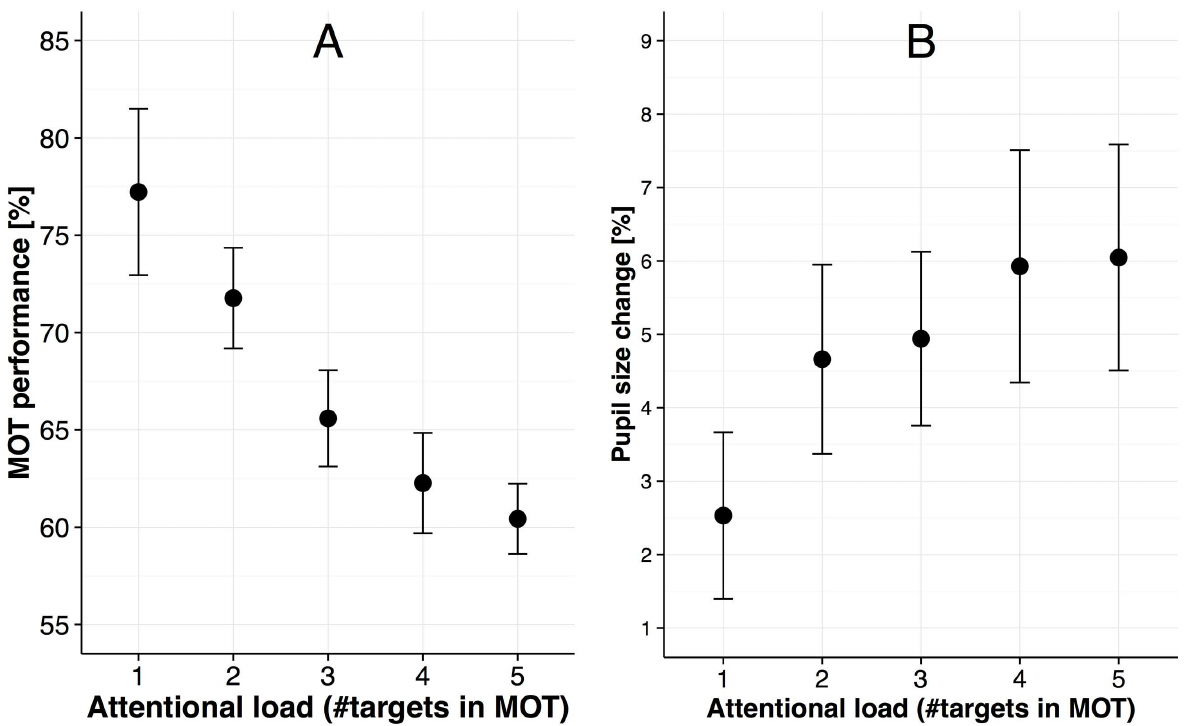
Fig 4. Control experiment results. (A) MOT task performance (i.e., fraction of correctly selectedtargets) as a function of attentional load and task experience. (B) Pupil size changerelative to the passive viewingconditionas a function of attentional load. Error bars in all panelsare standard error of the